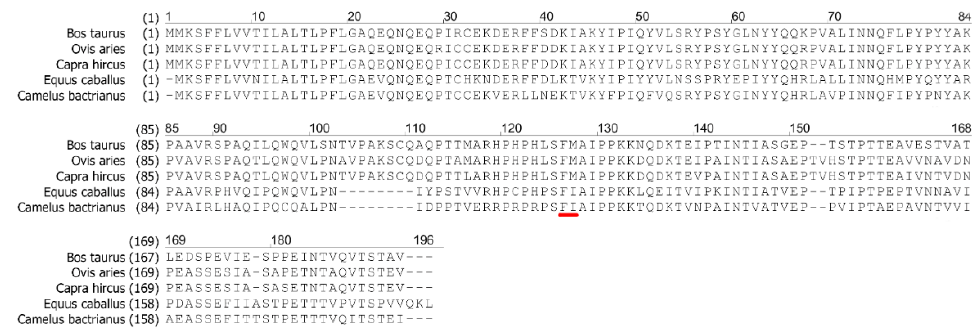
Figure 4. Amino acid sequences for κ -casein of cow, sheep, goat, horse and camel. Underlined red region indicates chymosin specific cleavage site.